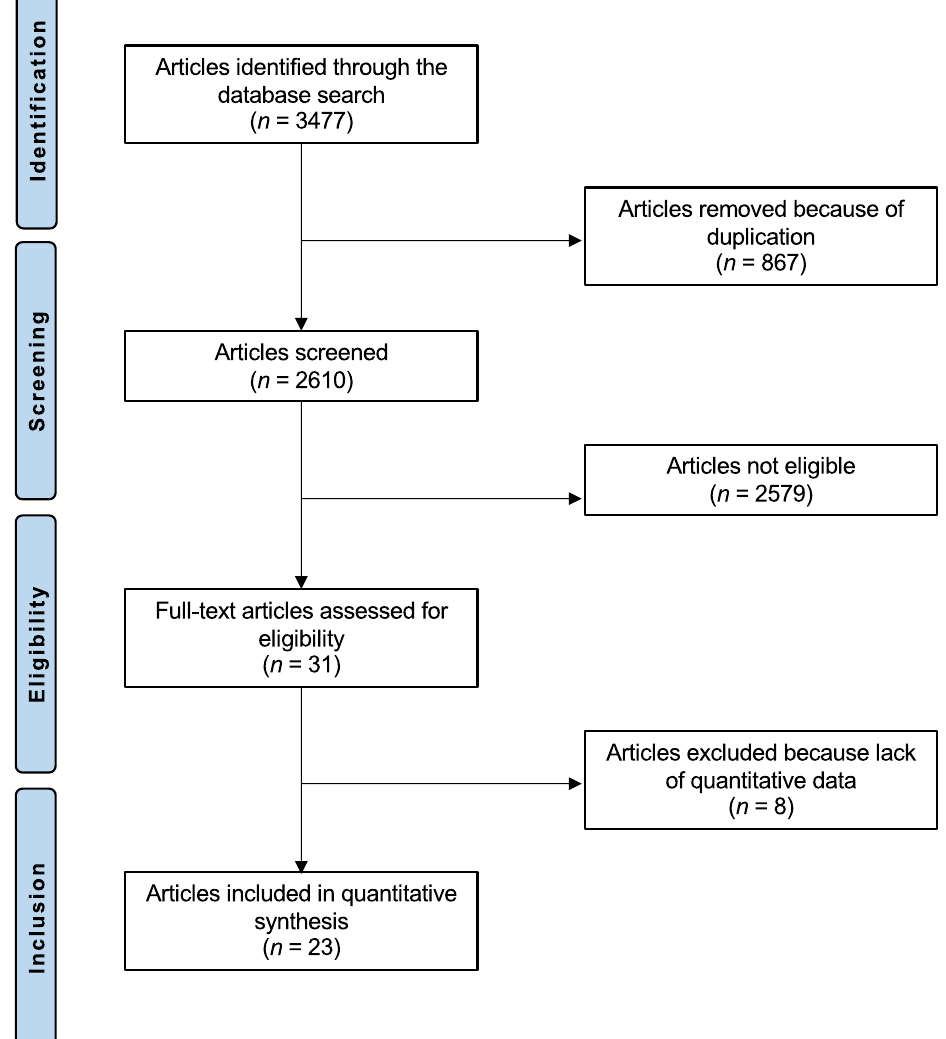
Figure 1. PRISMA flow chart of the literature